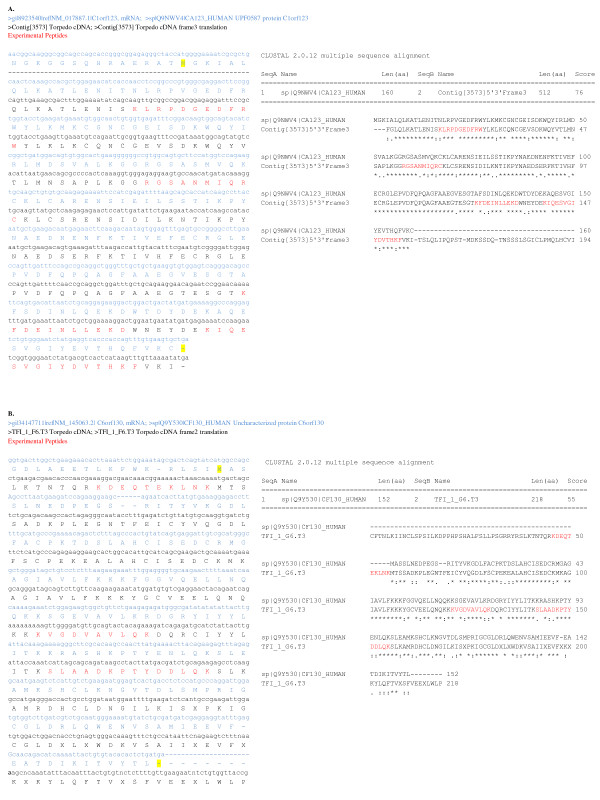
Sequence alignments between uncharacterized human open reading frames (ORF) and Torpedo cDNA. Two human ORFs were identified by tandem mass spectrometry (MS/MS) analysis of electric organ fractions by the SEQUEST algorithm in BioWorks 3.3.1 software, crossreferencing our in-house Torpedo californica cDNA library translated into six reading frames. Comprehensive alignments of nucleotide and protein sequences between uncharacterized human ORFs (blue text) and Torpedo cDNA (black text) were compiled from individual ClustalW alignments (default parameters with gonnet matrix) for C1orf123 (a) and C6orf130 (b). ClustalW protein alignment is shown separately to highlight protein sequence similarity with the translated cDNA sequence (Expasy translate tool) and peptides identified by mass spectral mapping (highlighted in red). Start and stop amino acids are highlighted in yellow.